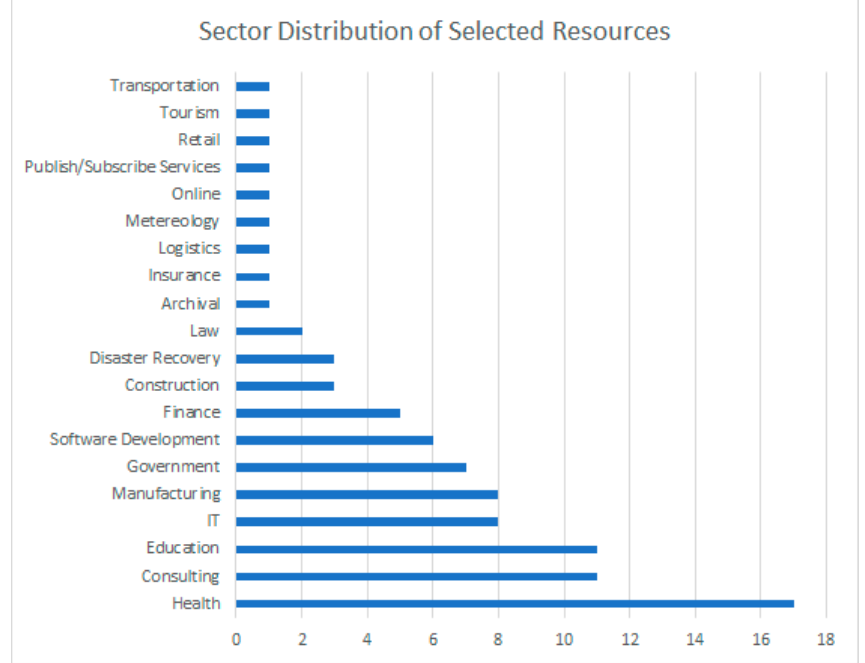
Figure 2. Sector Distribution of Selected